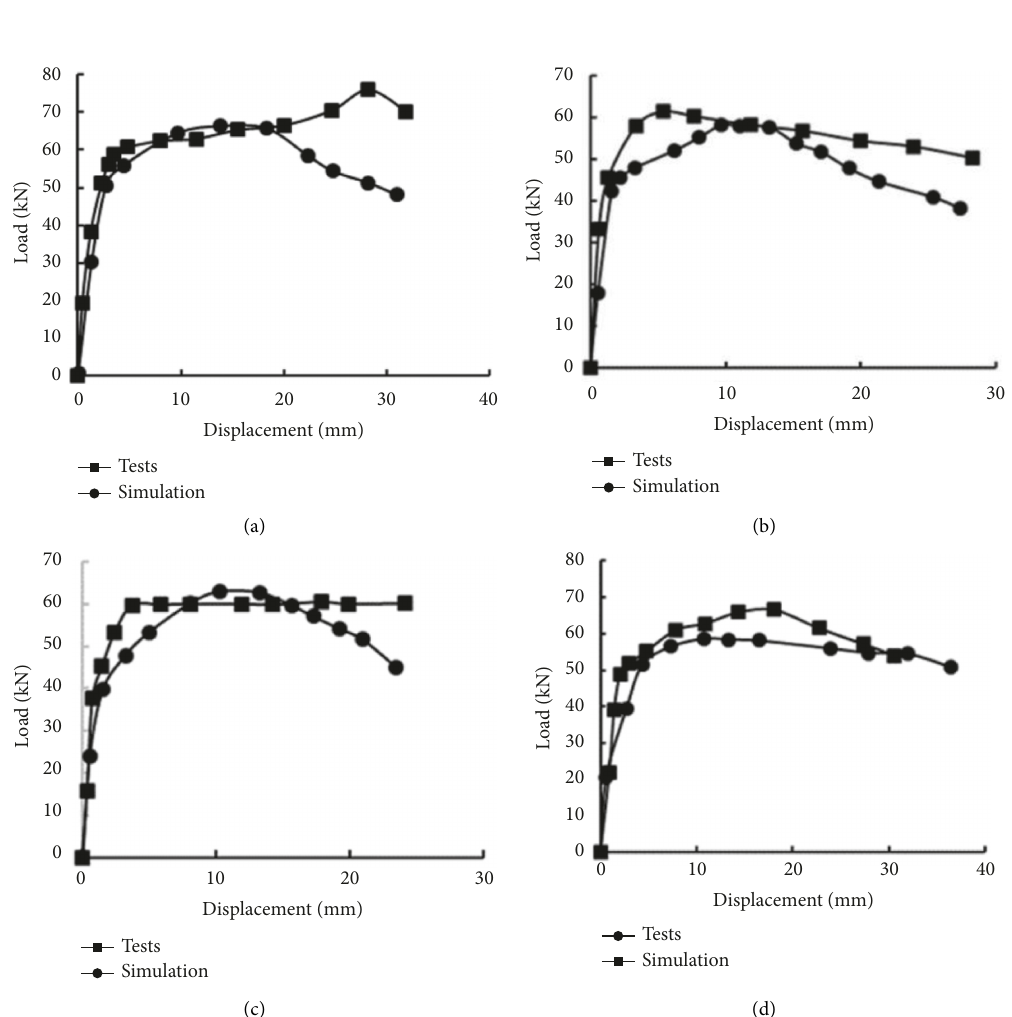
Figure 12: Comparison of experimental and numerical simulation results. (a) Specimen XJ1. (b) Specimen ZP2. (c) Specimen XJ2. (d) Specimen